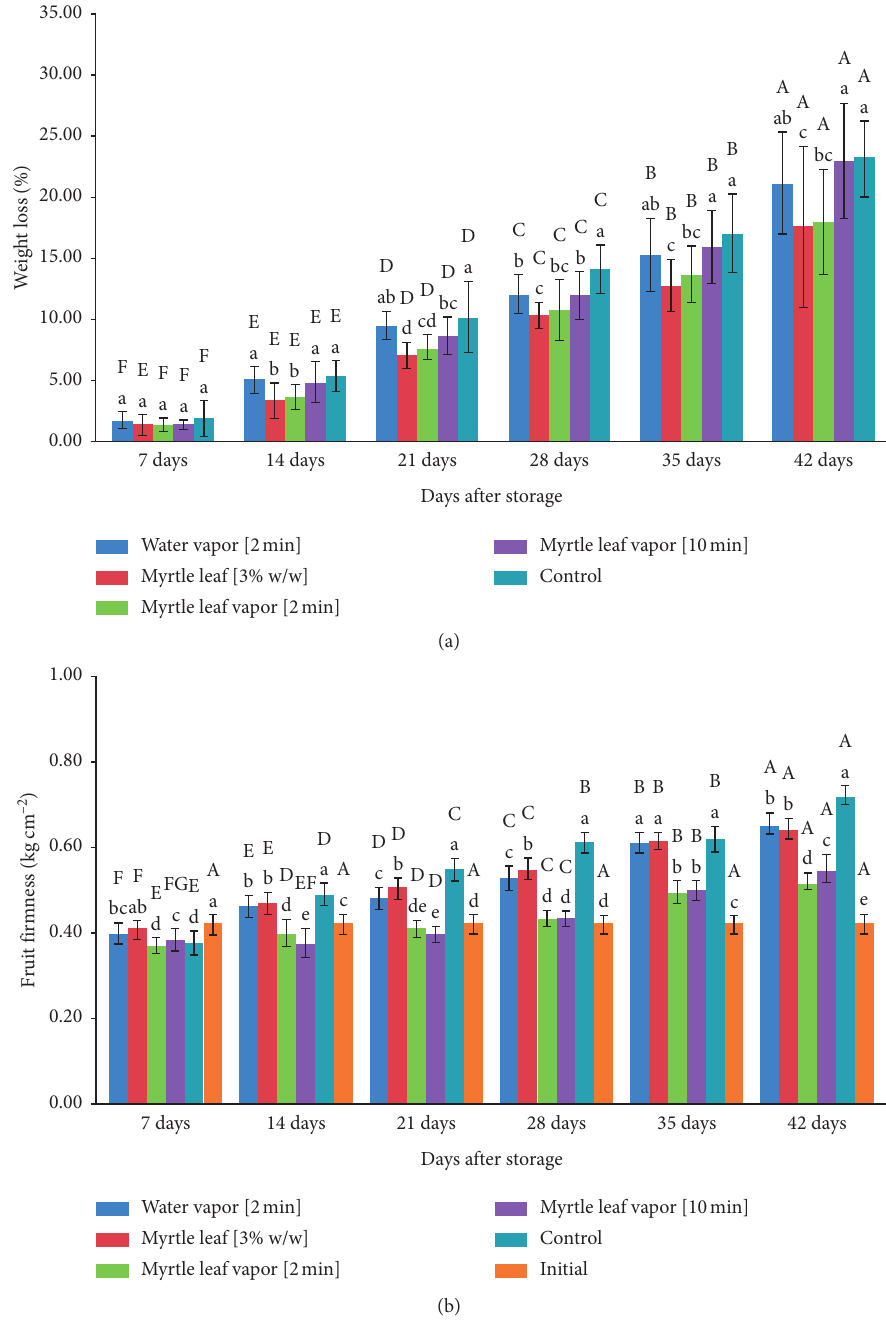
Figure 1: Effects of volatile essential oils of myrtle leaves on the (a) weight loss and (b) fruit firmness of loquat fruits during 42 days of storage. Different lowercase letter denote significant differences among different treatments for the same sampling time, and different capital letter denotes significant differences among different sampling times for the same treatment, according to Tukey’s HSD test at P ≤ 0 . the minimum TA content (1.32 g 100 ml − 1 malic acid) was measured from the myrtle leaf vapor (2 min) (Figure 3(b)).